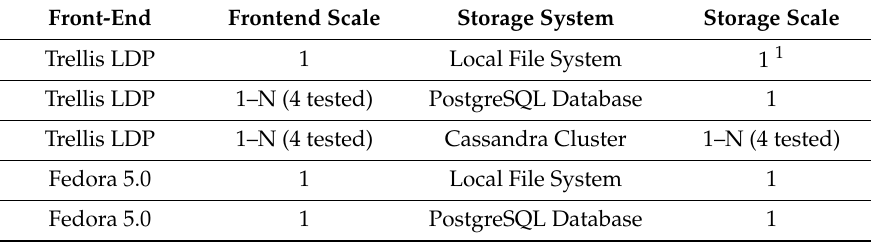
Table 1. Software stack configurations most often subjected to performance